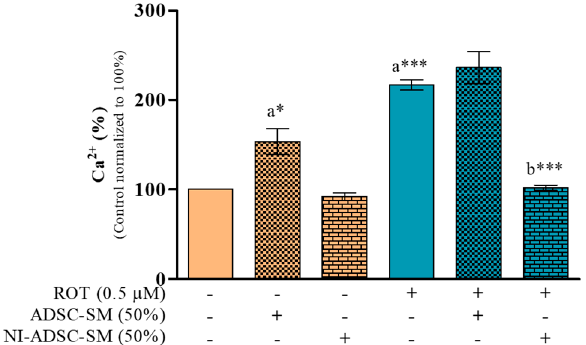
Figure 1. Effect of the NI-ADSC-SM on ROT-induced Ca 2+ levels. SH-SY5Y cells seeded at 50,000 cells/mL in DMEM containing 1% FBS and incubated overnight were in the presence of ROT (0.5 µ M) or DMSO for 48 h alone or with the ADSC-SM or NI-ADSC-SM (each diluted by 50%) during the last 24 h as depicted in Supplementary Figure S1b. Intracellular Ca 2+ levels were assessed using the fura-2AM assay. Data are shown as the means (bars) and SEM (error bars) of three independent cell culture experiments. Statistical analysis was performed using one-way ANOVA with Tukey’s post-test. Statistical comparisons: a—compared with control; b—compared with ROT; * p < 0.05 and *** p < 0.001.